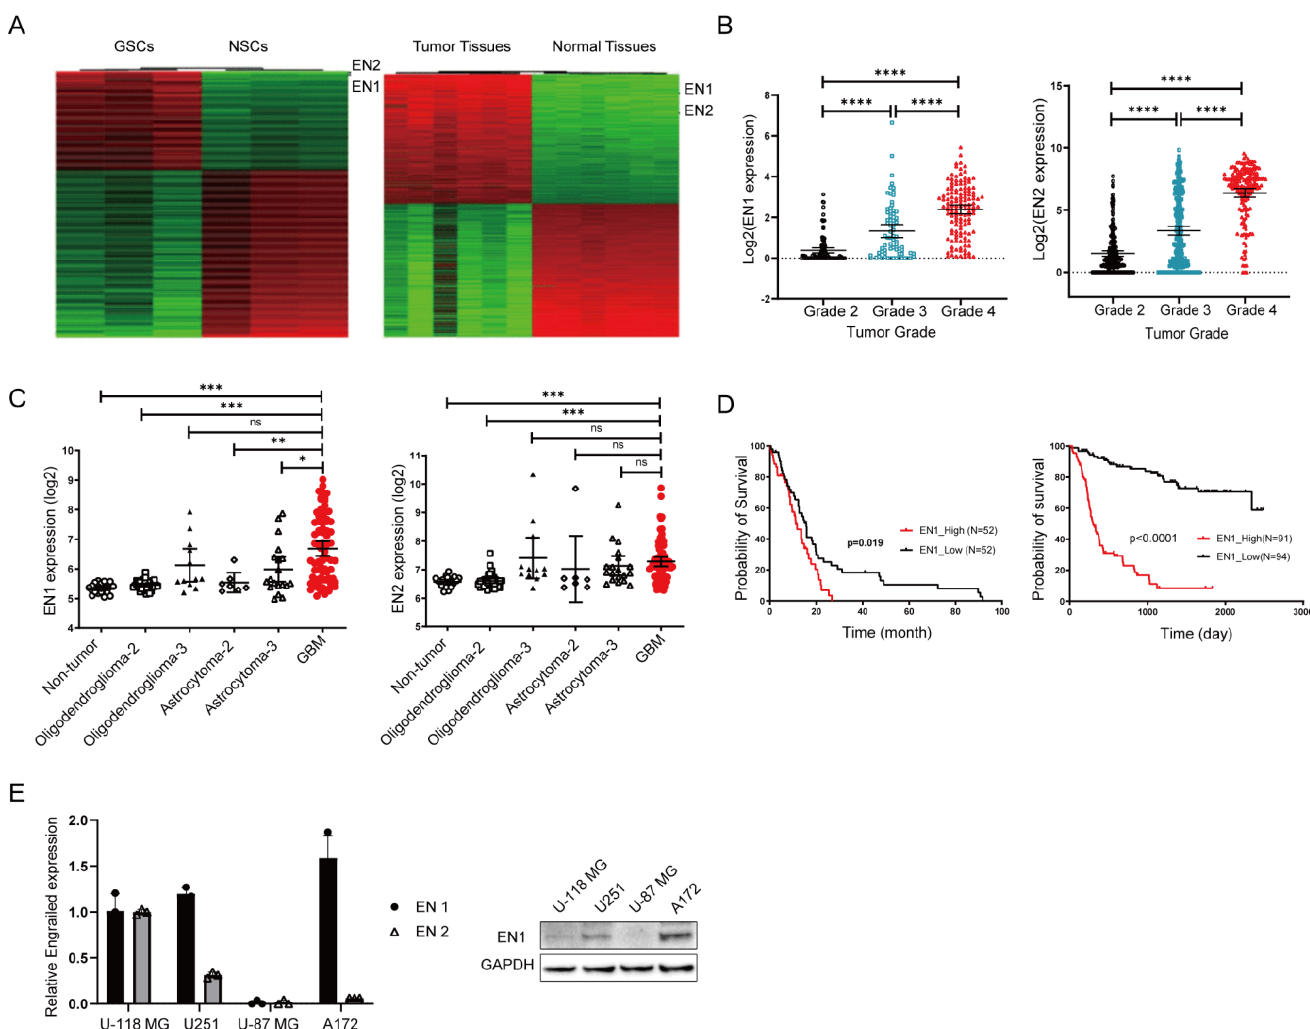
Figure 1. Elevated EN expression is associated with glioma cancer progression. ( A ) RNA-seq results for mouse glioma stem cells lines vs. neural stem cells (left) and for mouse brain tumor tissues vs. normal brain tissues (right). ( B ) The expression of EN1 (left) and EN2 (right) in glioma samples from TCGA database. Black, blue and red color is for Grade 2, 3 and 4 respectively. ( C ) Analysis using the Henry Ford Hospital dataset, showing correlation between the EN1 (left) and EN2 (right) gene expression levels and glioma patient tumor grade ( ○ for Non-tumor, □ and ▲ for Oligodendroglioma-2 and 3, ◊ and ∆ for Asreocytoma-2 and 3, red ● for GBM). ( D ) Correlation between glioma patient survival and the EN1 expression level from TCGA glioblastoma database (left) and the Chinese Glioma genome Atlas gliomas database (right). ( E ) For the indicated glioma cell lines, Engrailed 1 expression assessed by qPCR (left) and Engrailed 1 accumulation assessed by immunoblotting (right). * p < 0.05, ** p < 0.01, *** p < 0.001, **** p < 0.0001 and ns (no significant) ac- cording to Student’s t -test.